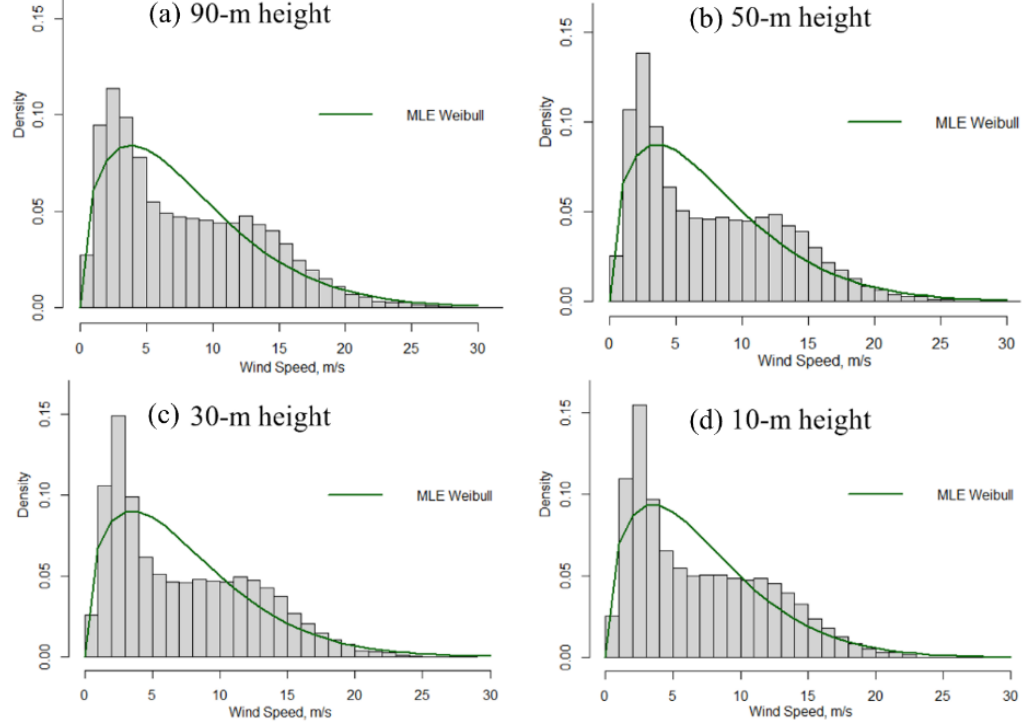
Figure 7. The relative histogram and fitted Weibull density of the wind speed at different heights ( a ) 90 m, ( b ) 50 m, ( c ) 30 m, ( d ) 10 m.